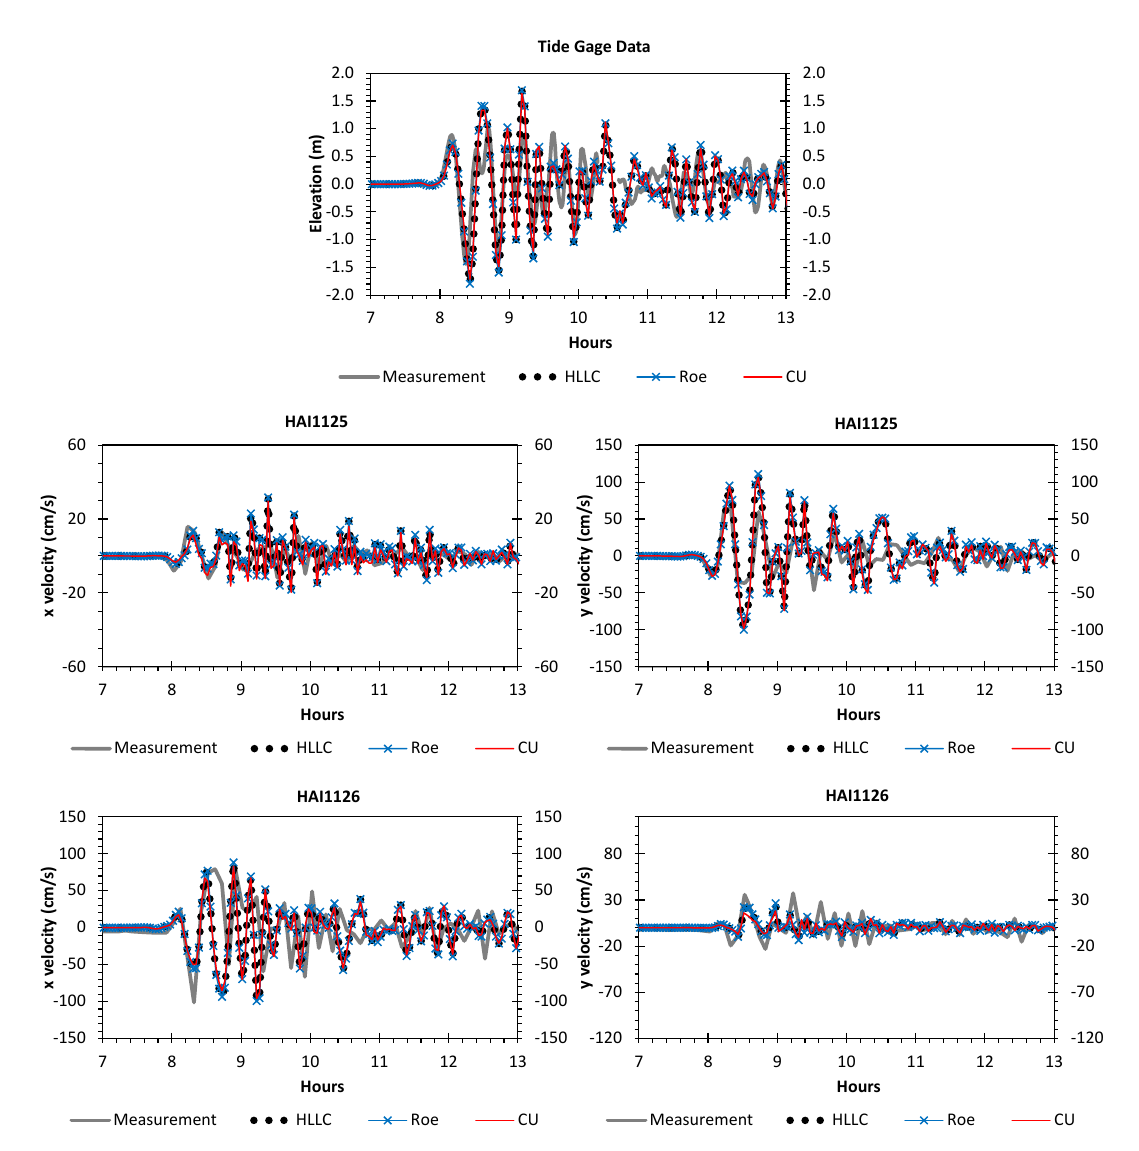
Figure 15. Case 4: comparison between observation and numerical